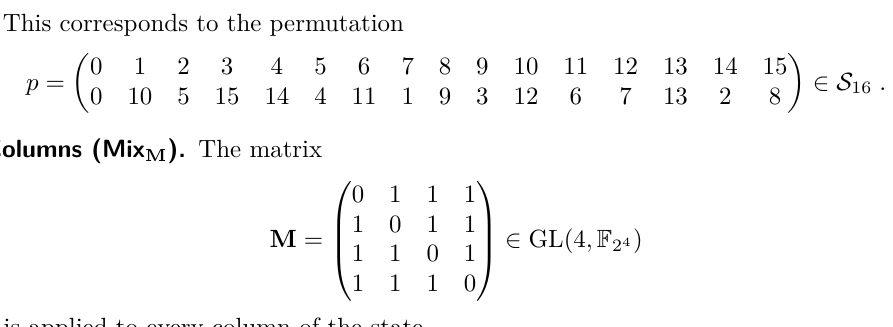
Table 1: The 4-bit S-box used in Midori64 . We give the values for x and S ( x ) as elements in F s with respect to the natural basis, e.g., b represents the vector (1 , 0 , 1 , 1). 2 x 0 1 2 S ( x )